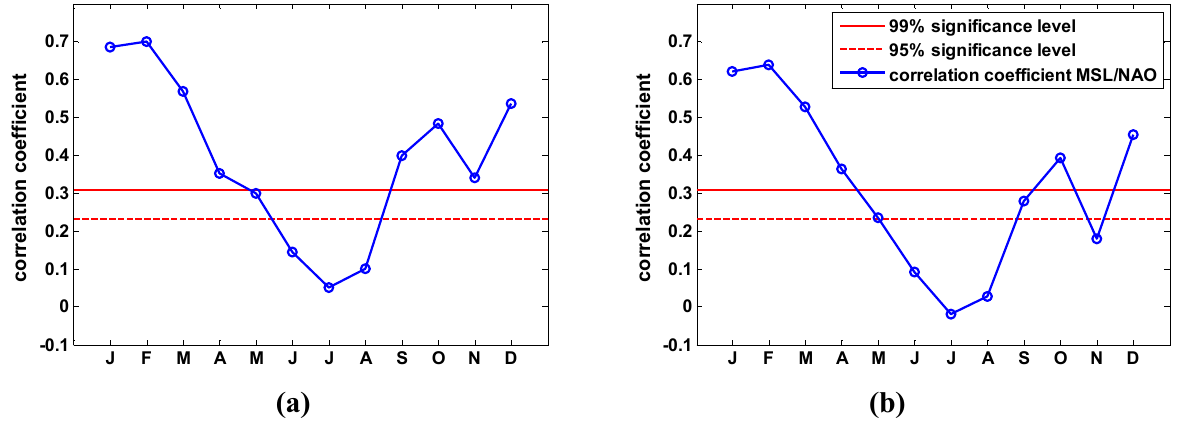
Figure 5. Correlation coefficients between NAO and MSL for the period 1937–2008. ( a ) shows the relationship for the virtual station ‘Schleswig Holstein’; ( b ) shows the relationship for the virtual station ‘Lower Saxony’. The thicker horizontal red lines show two significance levels by using a